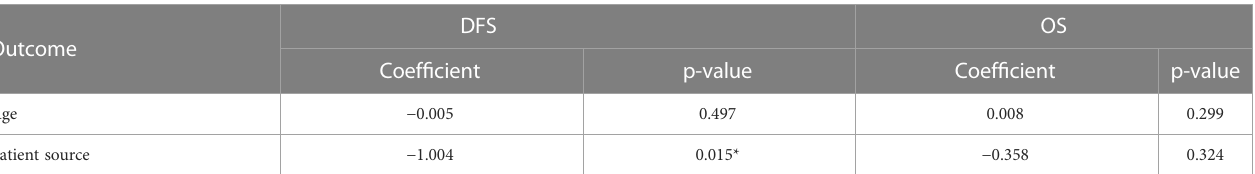
TABLE 2 Multivariate meta-regression analysis for FLT3-TKD in patients of AML.